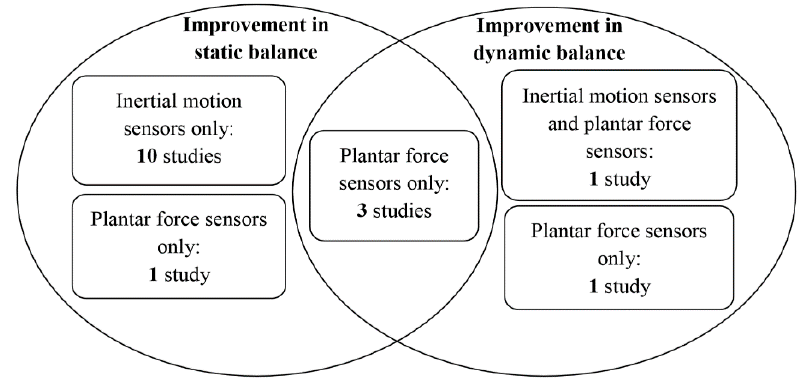
Figure 2. Overview of effectiveness of the devices and type of sensors.